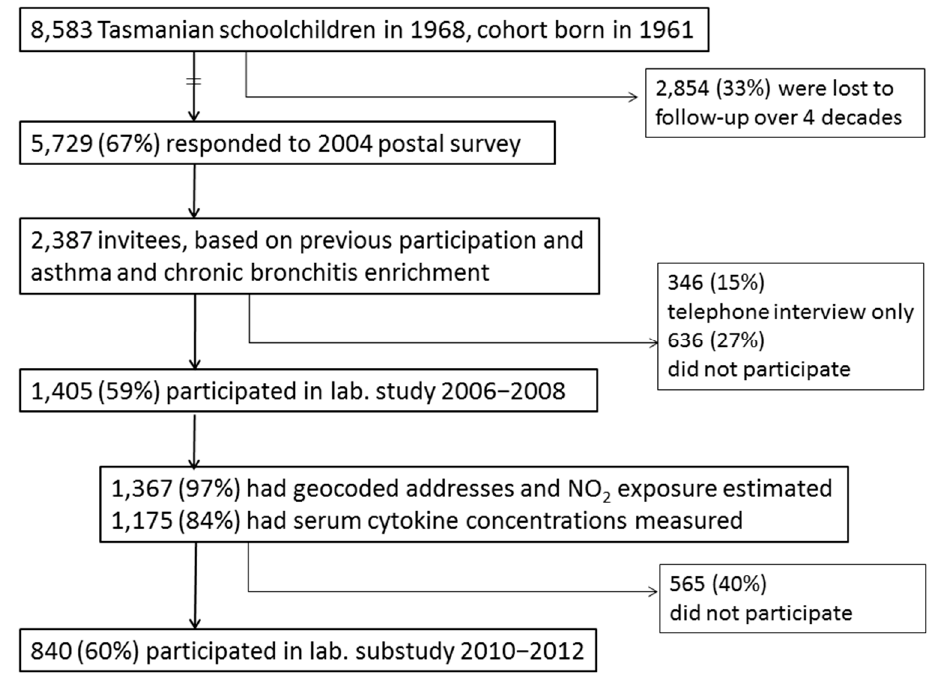
Figure 1. Tasmanian Longitudinal Health Study flow diagram